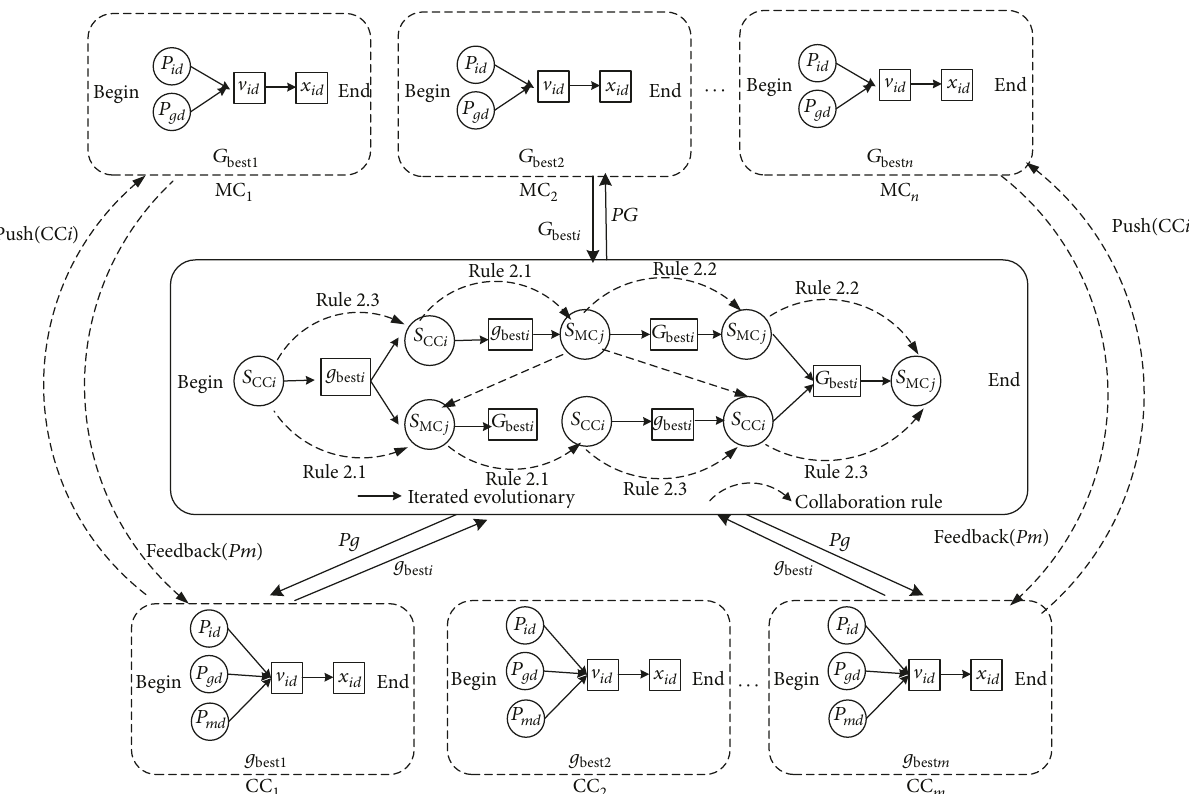
Figure 4: The multicommunity bidirectional drive